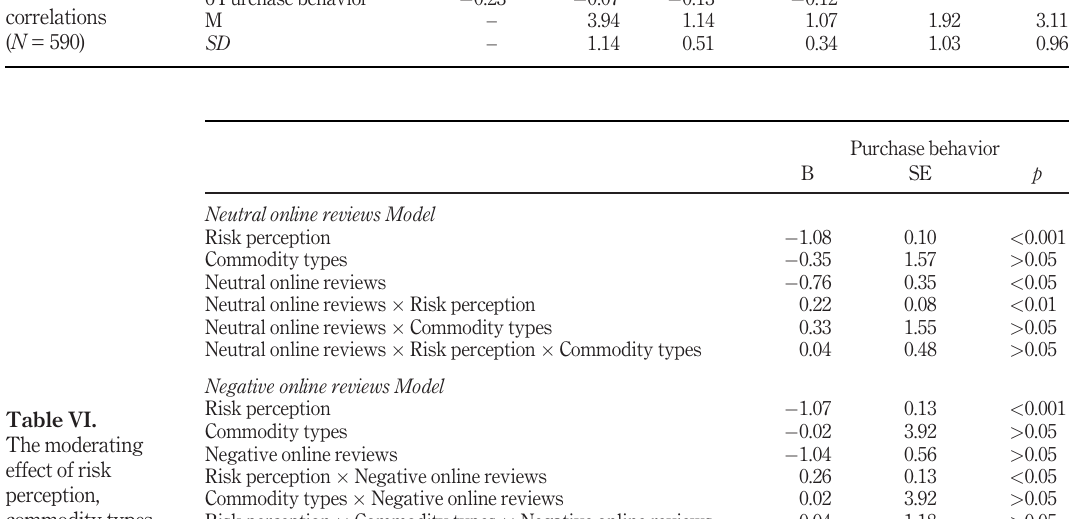
and bivariate correlations